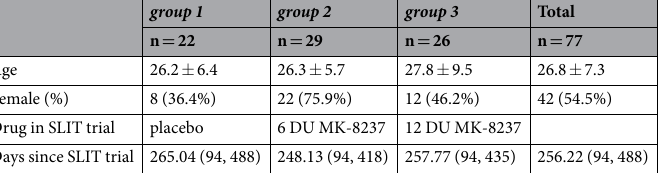
Table 1. Characteristics of subjects undergoing airway allergen challenge with house dust mite extract at the Vienna Challenge Chamber (VCC) after participating in a sublingual immunotherapy (SLIT) trial. Values present mean ± SD or mean (minimum, maximum); DU developmental